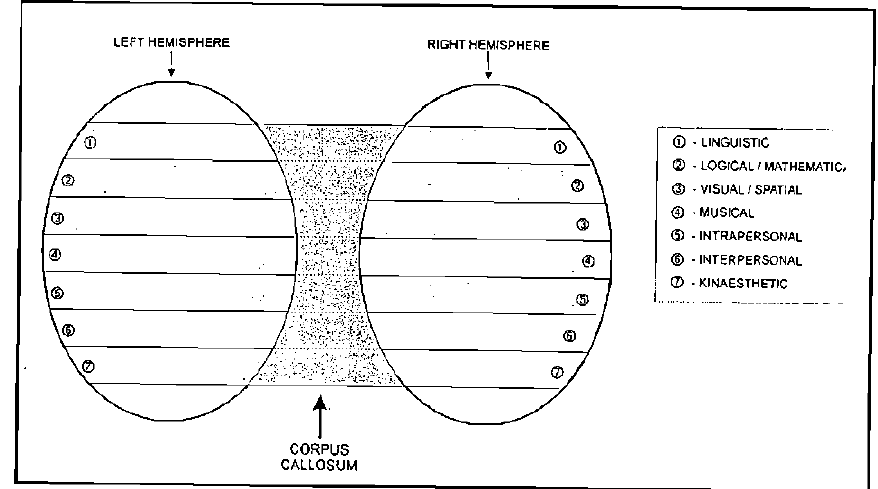
FIGURE 4: A Schematic Representation of the Neurobiological Arrange- ments of the Metacognitive